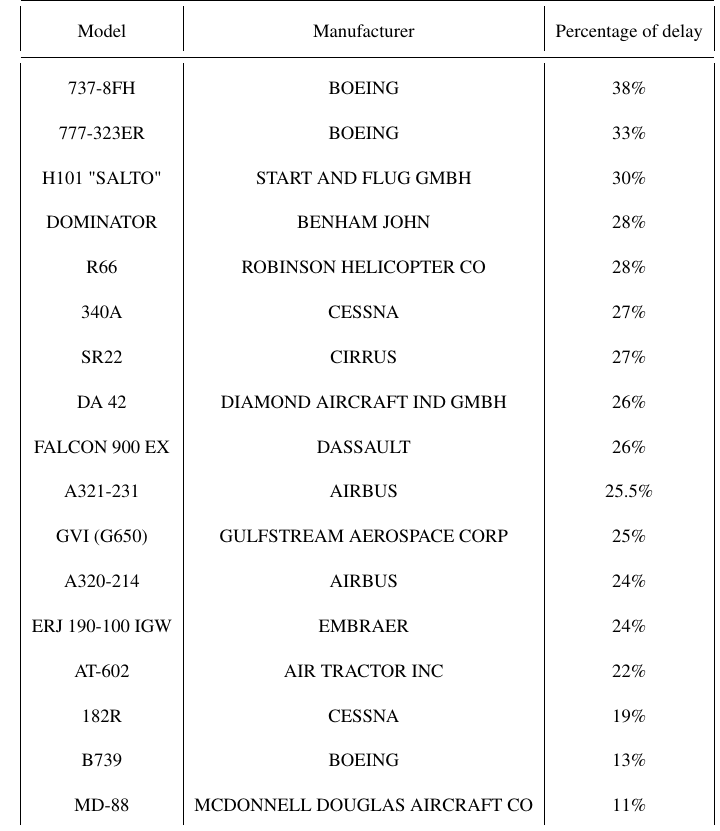
Table 1. Delay percentage of the most common aircraft types in the dataset